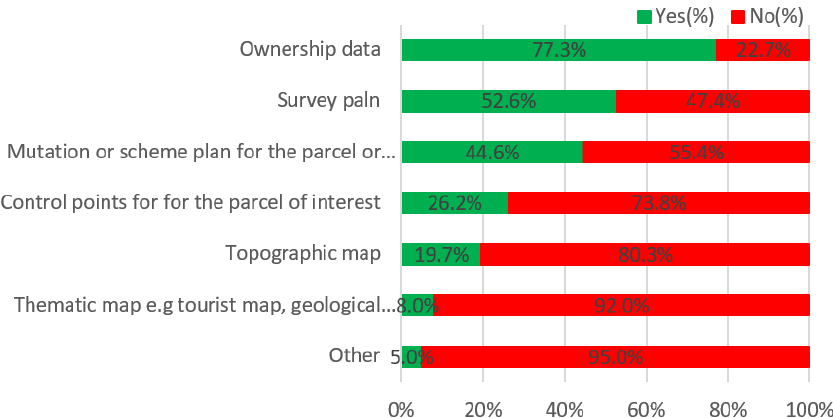
Figure 5. Schematic data requests while making inquiries ( n = 401).